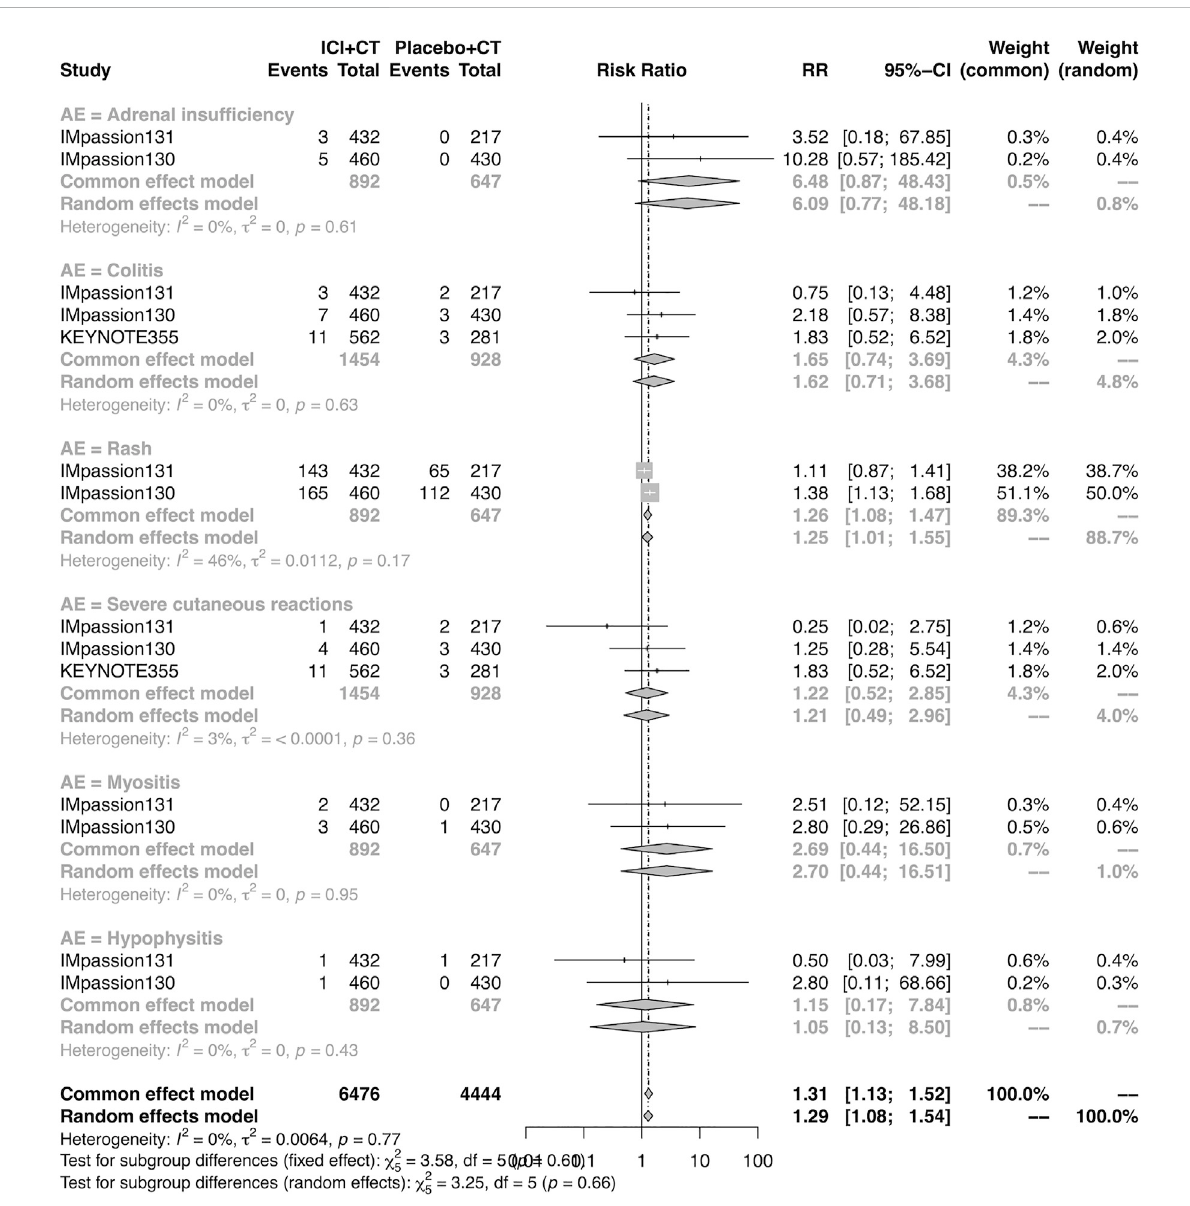
FIGURE 9 Pooled speci fi c AEs in any grade in adjuvant therapy clinical trials. AEs, adverse events; RR, relative risk; 95% CI, 95% con fi dence interval; ICIs, immune checkpoint inhibitors; CT,